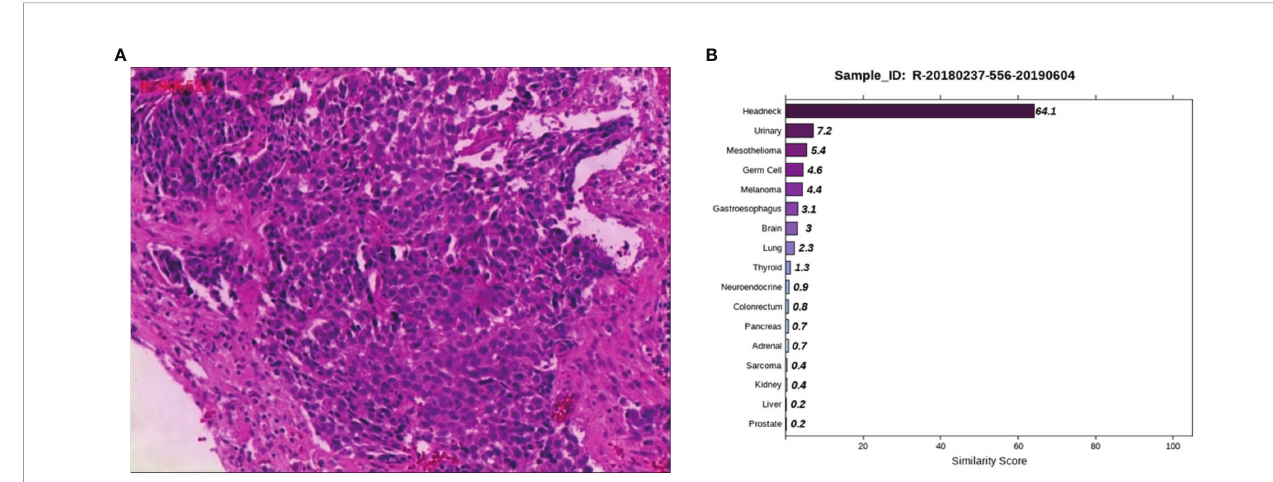
FIGURE 3 | Pathological and 90-gene expression assay results of case 3. (A) The pathological diagnosis of the resected specimens was metastatic poorly differentiated carcinoma. Immunohistochemistry staining: CK-pan, Ki-67, P63, P40 were positive respectively. (B) The 90-gene expression assay indicated that the similarity score of bone biopsy tissue is head and neck tumor metastasis was